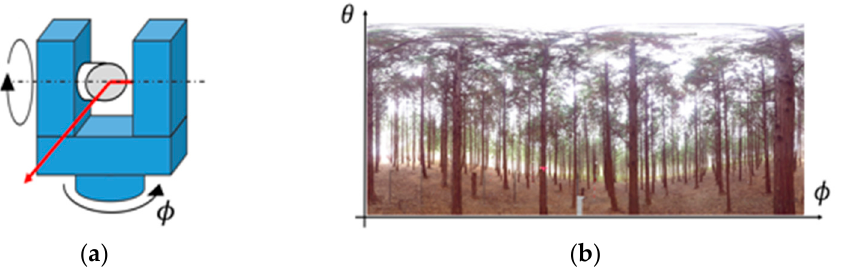
Figure 4. Measurement by TLS. ( a ) Conceptual diagram of TLS measurement; ( b ) Example of a point cloud with a two-dimensional lattice structure.